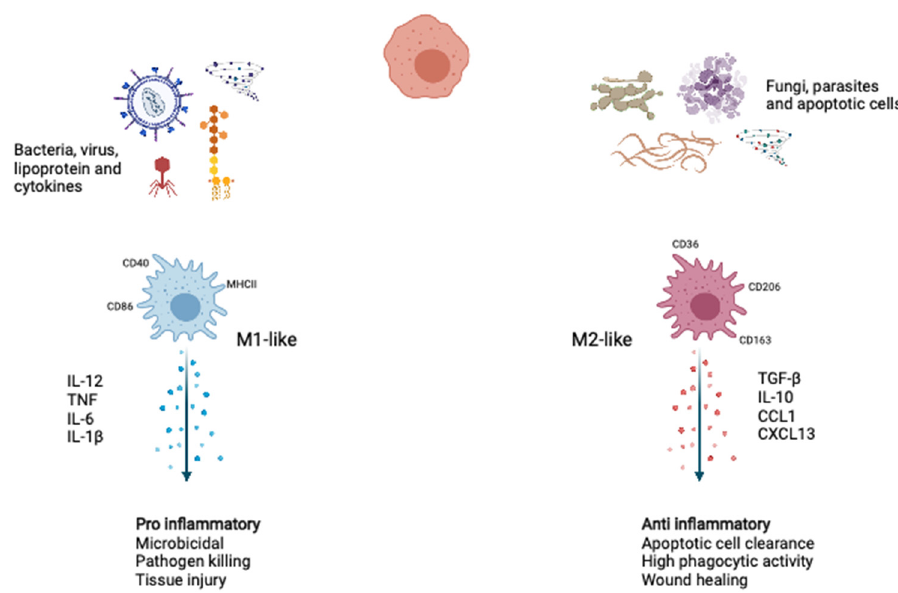
Figure 1. Macrophage polarization. During activation upon stimuli, such as type 1 cytokine, intra- cellular pathogens, and lipoproteins, the macrophages polarized to the M1-like phenotype show inflammatory and microbicidal. Upon stimuli, such as apoptotic cells and type 2 cytokines, the macrophages polarized to the M2-like phenotype function as anti-inflammatory, wound healing, and apoptotic cell clearance. IL-12, Interleukin-12; TNF, tumor necrosis factor; IL-6, Interleukin-6; IL-1 β , Interleukin-1 β ; TGF- β , tumor growth factor- β ; IL-10, Interleukin-10; CCL1, C-C motif chemokine ligand 1; CXCL13, C-X-C motif chemokine ligand 13. Created with BioRender.com.